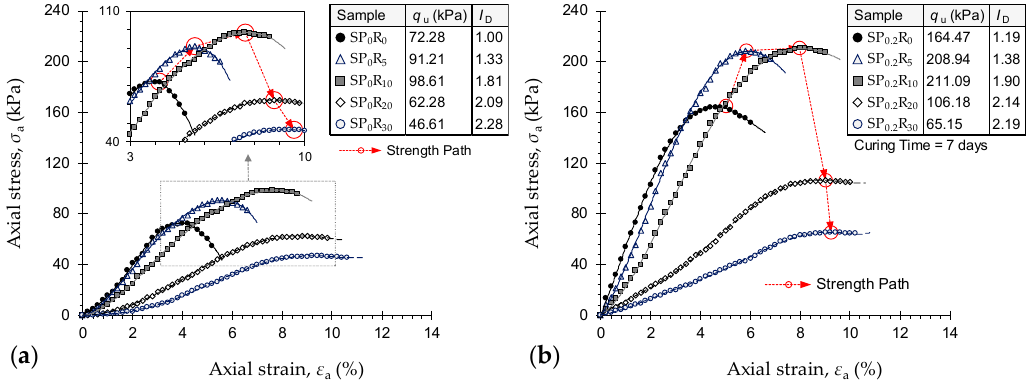
Figure 7. Stress–strain curves for the natural soil and various GR-blended samples: ( a ) Untreated— SP 0 R y where y = {0, 5, 10, 20, 30}; and ( b ) Treated with 0.2 g / L PAM at T c = 7 d— SP 0.2 R y where y = {0, 5, 10, 20, 30}.